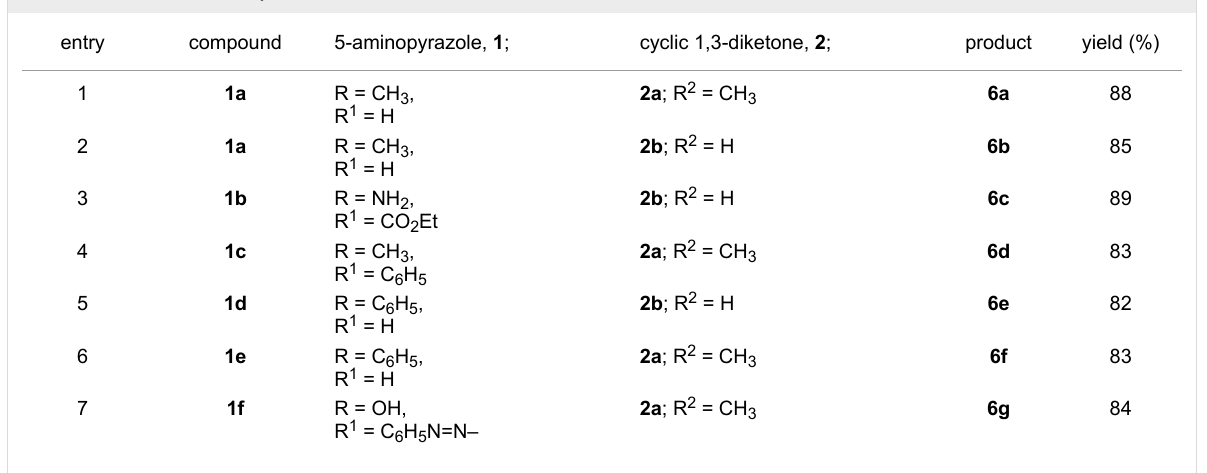
Table 1: Microwave-assisted synthesis of 4 and 6